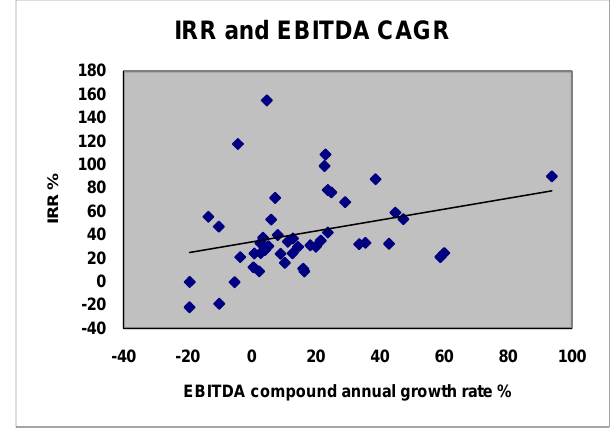
Figure 4: IRR and EBITDA CAGR scatter plot Earnings multiple